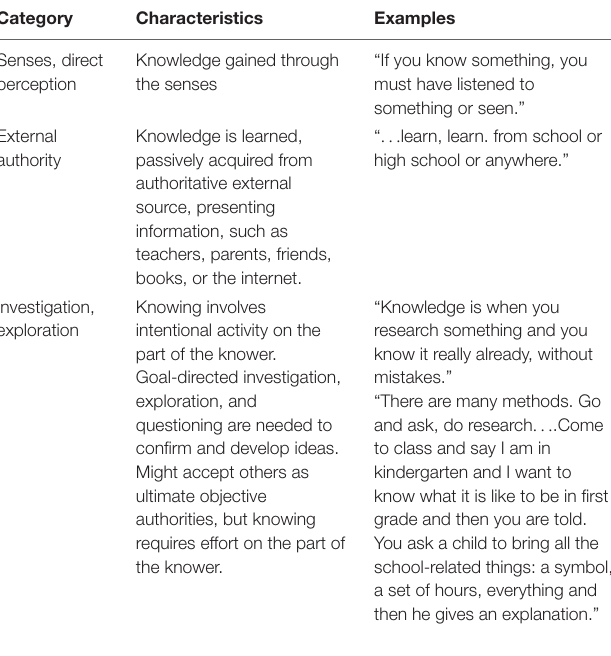
TABLE 2 | Category coding for theme of understandings of how knowledge is